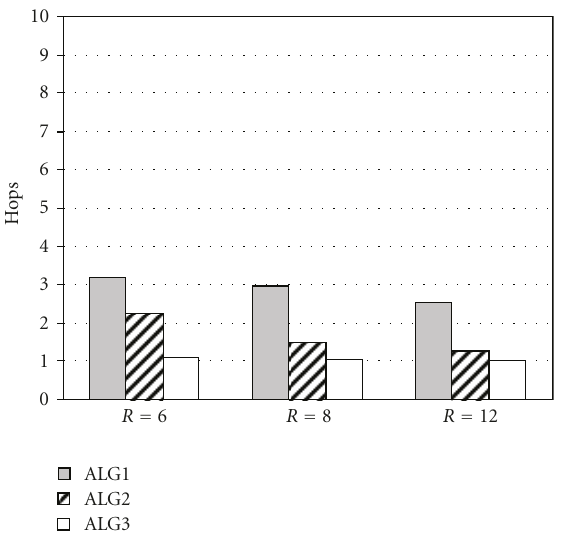
Figure 7: Average number of hops to get one proxy for a scenario with high connectivity ( τ = 6; ω = 50; P actual =